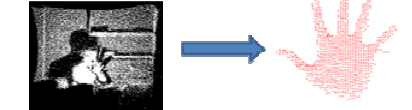
Figure 3: Objective of